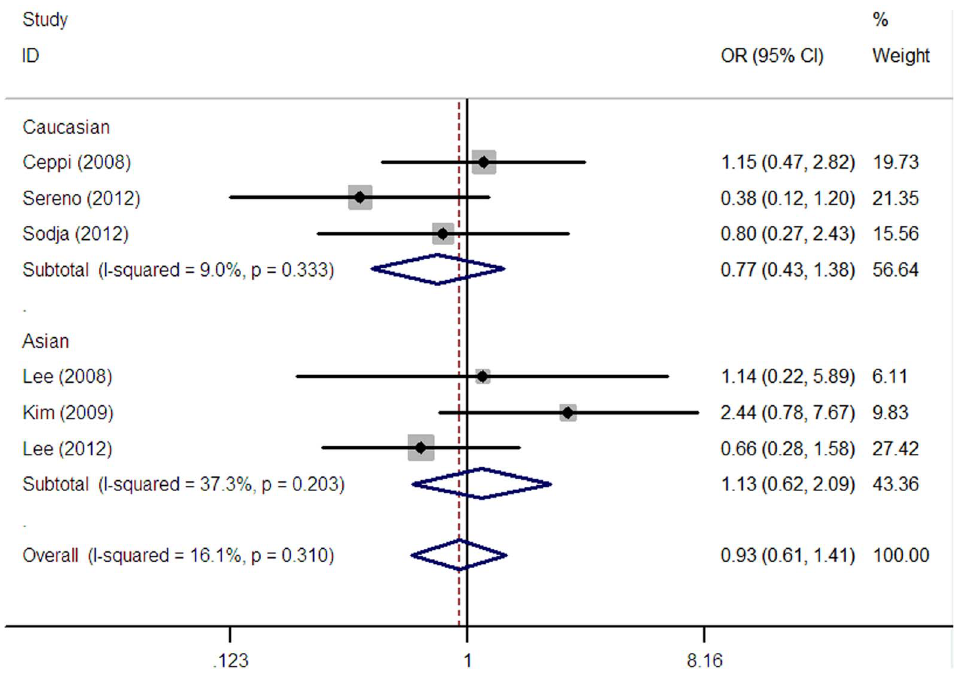
Figure 2. Forest plot for the association between ERCC1 level and objective response rate (ORR) in SCLC patients receiving platinum-based chemotherapy.